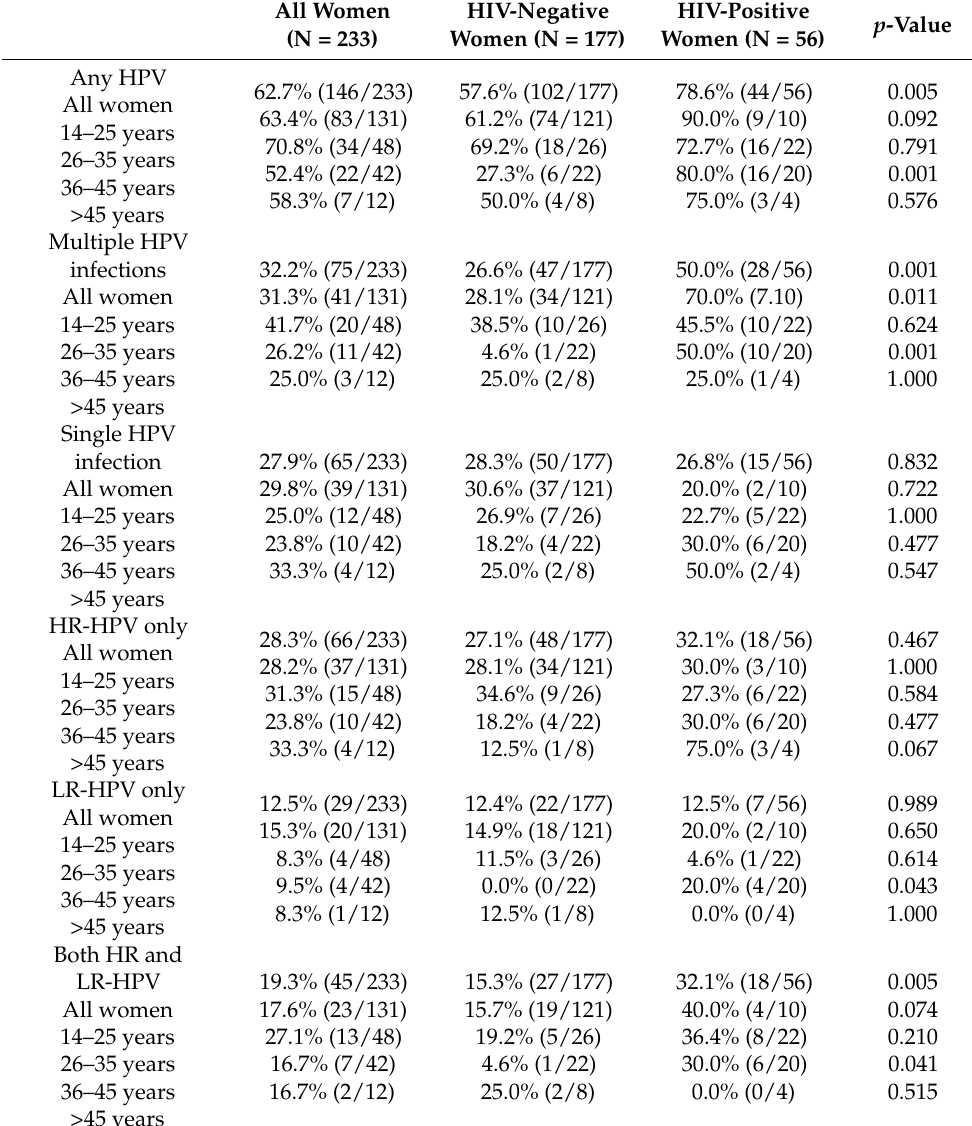
Table 2. Human papillomavirus (HPV) by age and human immunodeficiency (HIV) status. All